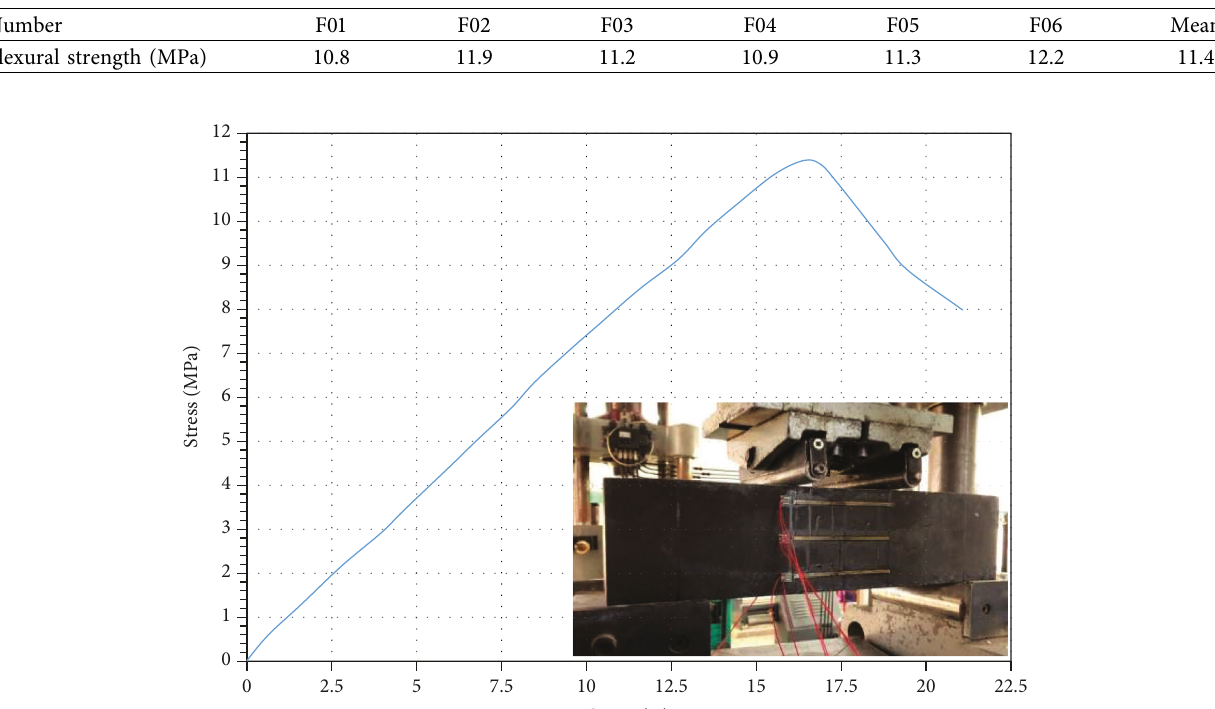
Figure 21: The tensile strength stress-strain curve of polyurethane concrete. Table 14: The flexural strength of polyurethane concrete.